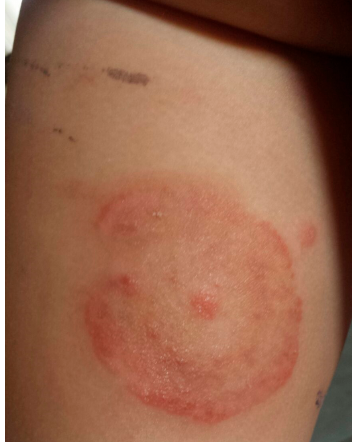
Figure 1. Tinea corporis due to M. canis in a child (case # 3).